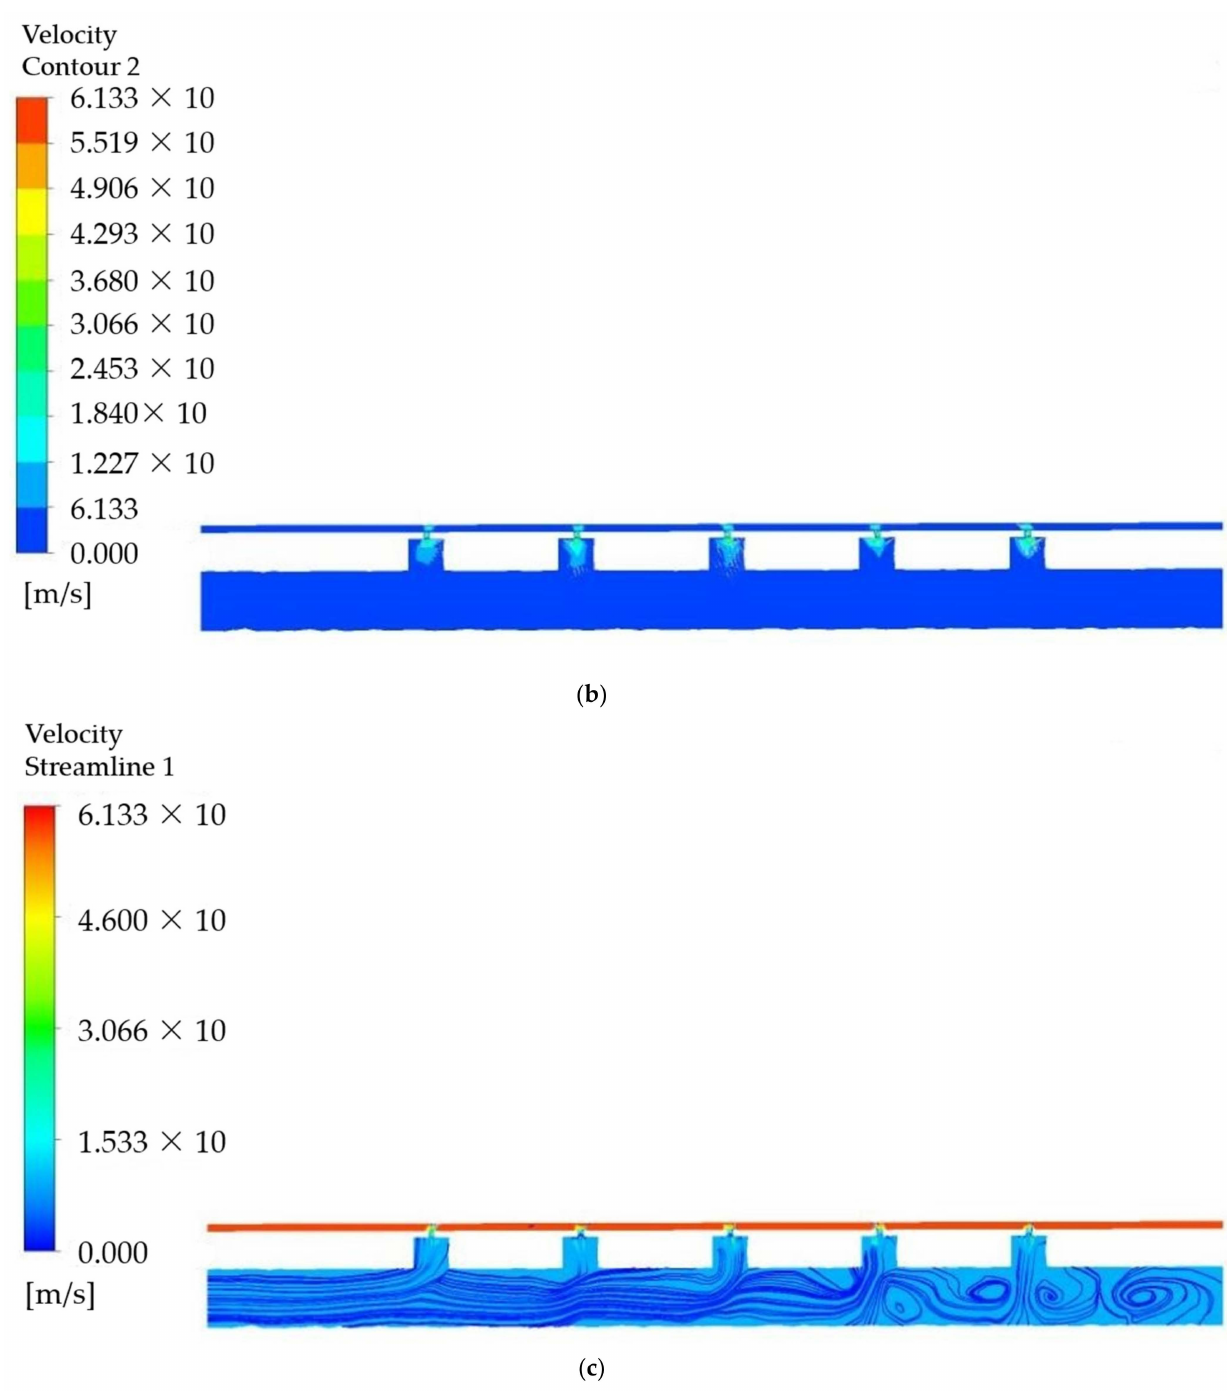
Figure 5. ( a ) The cloud chart of pressure distribution of 2 mm hole; ( b ) The cloud chart of velocity distribution of 2 mm hole; ( c ) The streamline diagram of velocity of 2 mm